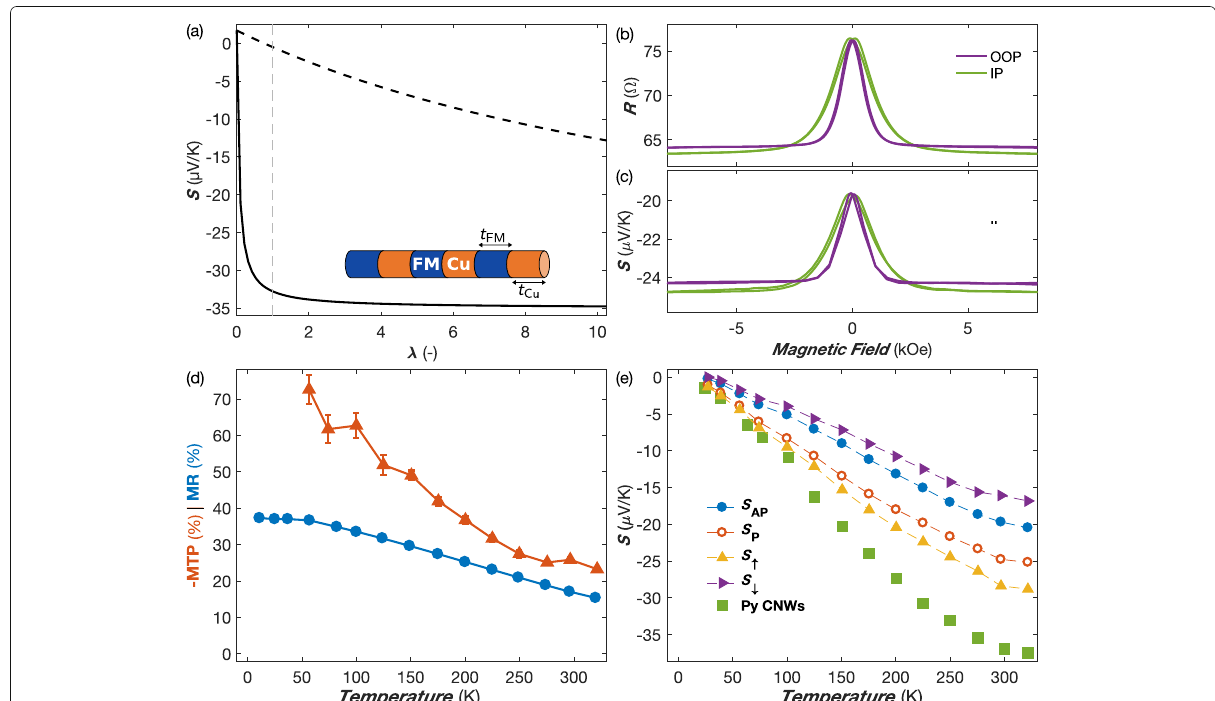
Fig. 3 a Calculated thermopower for Py/Cu multilayers in the layer parallel (dashed line) and perpendicular (solid line) directions vs thickness ratio / t λ = t Py Cu using Eqs. 1 and 2 and bulk values for transport coefficients. The gray dashed line shows the values for multilayer stack. b Room temperature variation of the electrical resistance and Seebeck coefficient of a Py/Cu NW network in magnetic fields applied in the IP and OOP directions. c MR ratio and MTP as a function of temperature with the field applied in the plane of the NW network films. d Measured Seebeck coefficients at zero applied field S AP (blue full circles) and at saturating magnetic field S P (red open circles), along with the corresponding calculated S ↑ (orange triangles) and S ↓ (violet triangles) from Eqs. 5 and 6 (see text). The data obtained on a Py NW network (80-nm diameter) are also reported (green squares). The error bars reflect the uncertainty of the electrical and temperature measurements and is set to two times the standard deviation, gathering 95% of the data